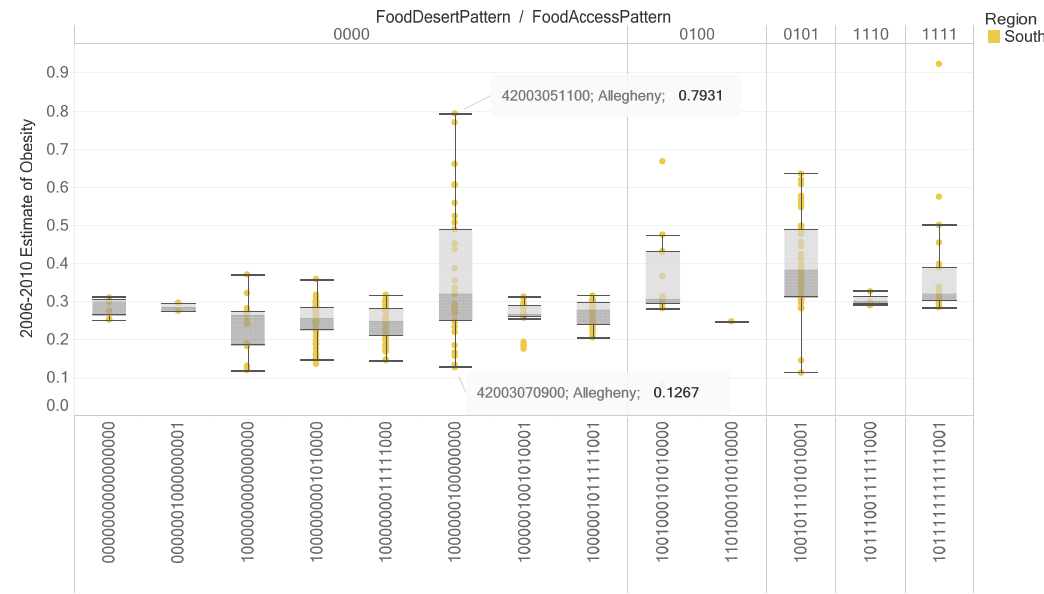
Figure 10. Regional comparison of estimates of obesity rates (2006–2010) for census tracts with the same food access pattern in Allegheny County, Southwest Pennsylvania. We designed the box plot to support decisions on differences in obesity rates in a county (attention and motivation functions of knowledge visualization). The design of the view allows one or more counties to be selected (elaboration function of the knowledge visualization).